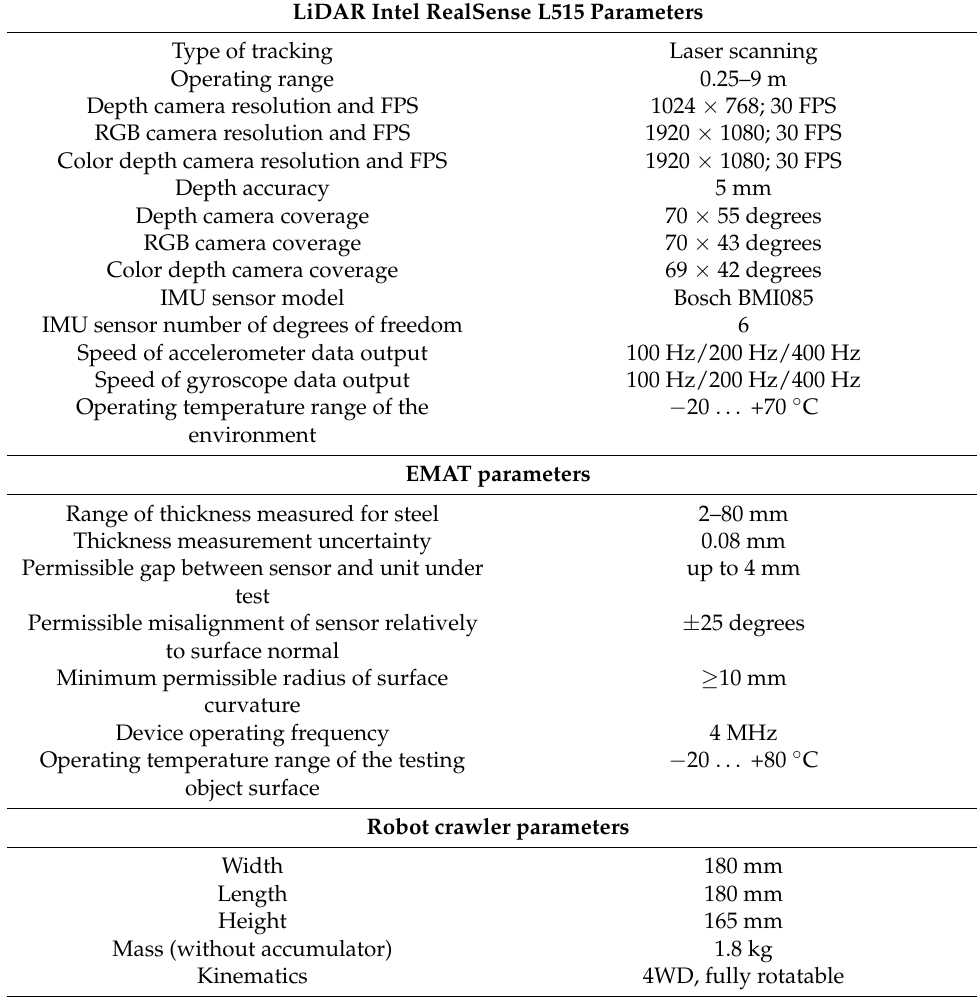
Table 3. Technical characteristics of the developed robot crawler.